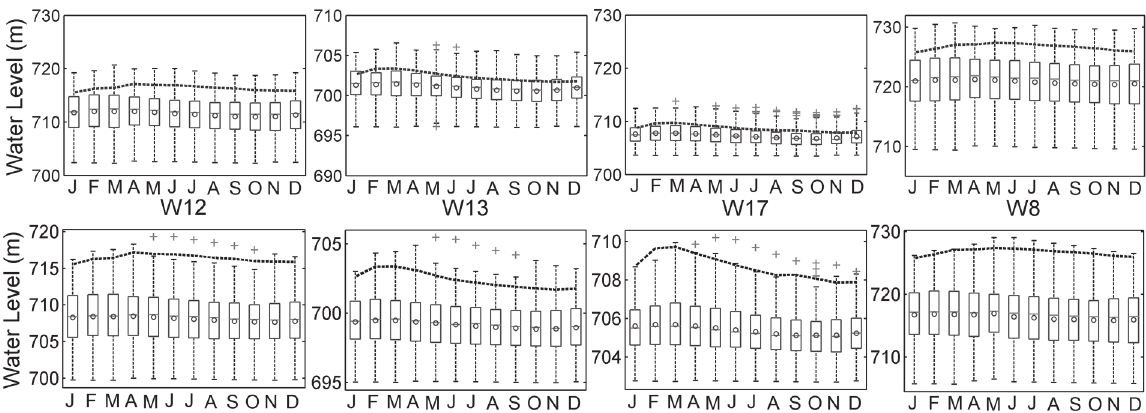
Figure 12 - Monthly means of observed (dashed line) and simulated (box-plot) water levels in the monitoring wells for the 2004- 2014 land use (upper graphs) and proposed land use change (bottom